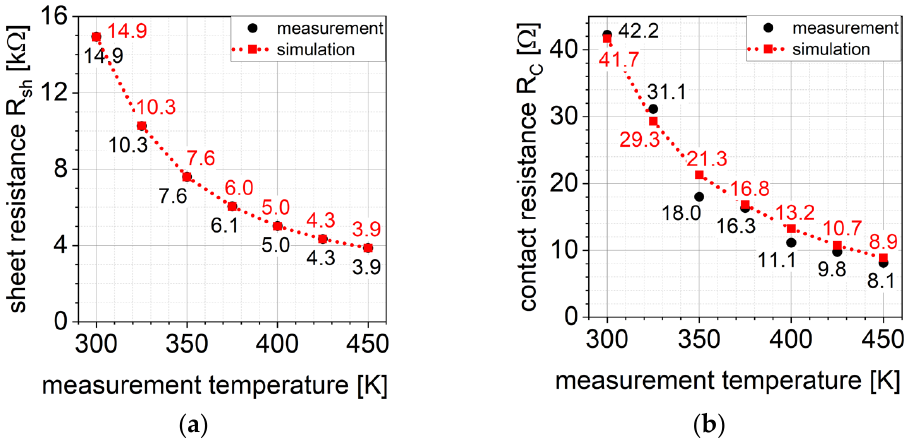
Figure 5. ( a ) Measured and simulated sheet resistance ( b ) Measured and simulated contact re- sistance.